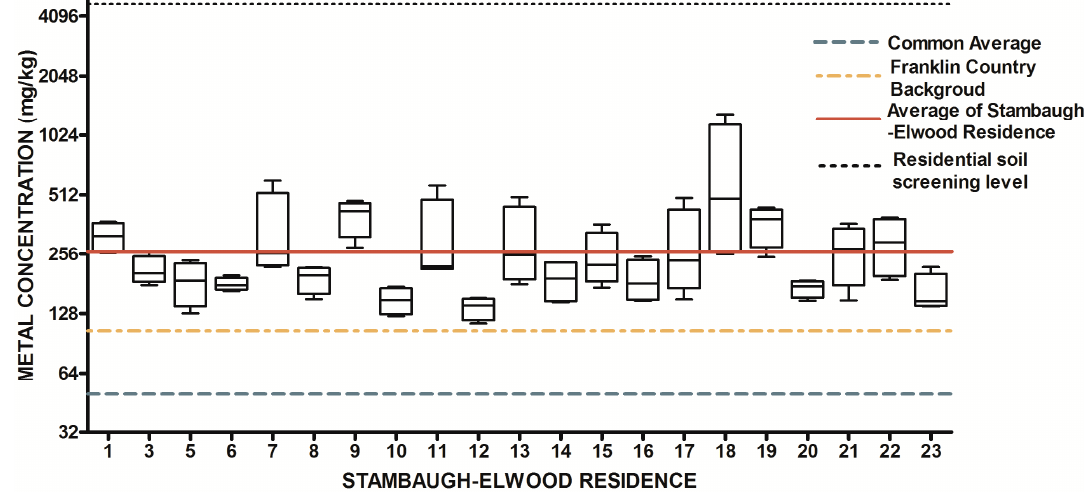
Figure 14. Residential urban soil level of Zn in the Stambaugh-Elwood community versus Franklin County (background), common averages and residential screening levels (RSLs) (mg/kg soil). Soil